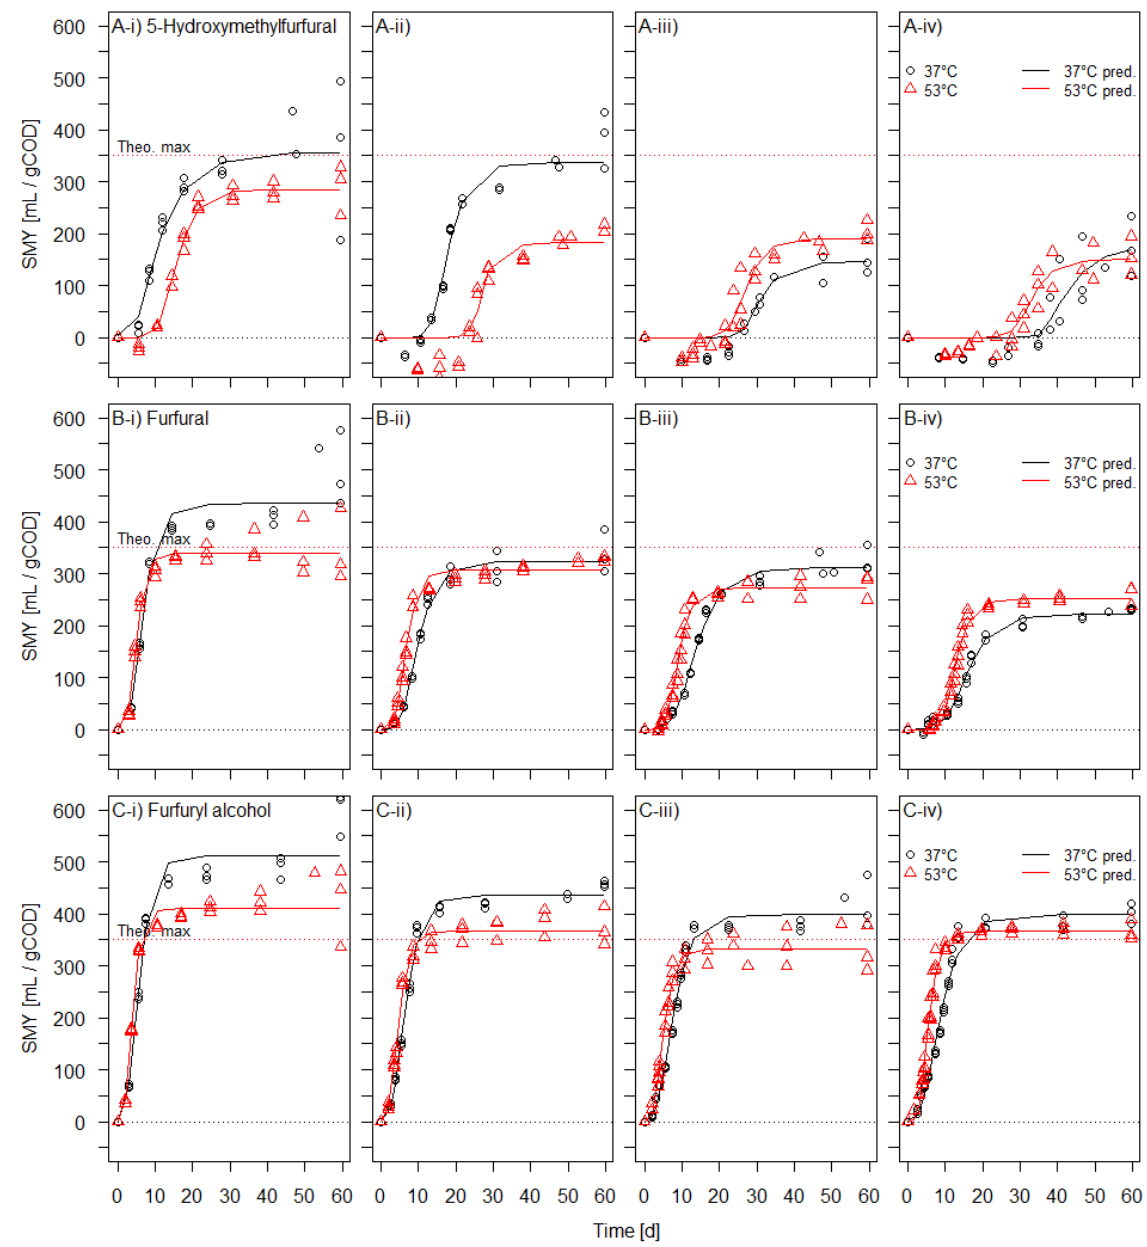
Figure 3. Measured specific methane yields for ( A ) 5-Hydroxymethylfurfural, ( B ) furfural, and ( C ) furfuryl alcohol from their per batch-test added amounts of ( i ) 0.1 gCOD, ( ii ) 0.2 gCOD, ( iii ) 0.3 gCOD, and ( iv ) 0.4 gCOD under mesophilic and thermophilic conditions, along with the fitted modified Gompertz function (n = 3 for all the test concentrations of the furanic compounds at 37 °C and 53 °C).